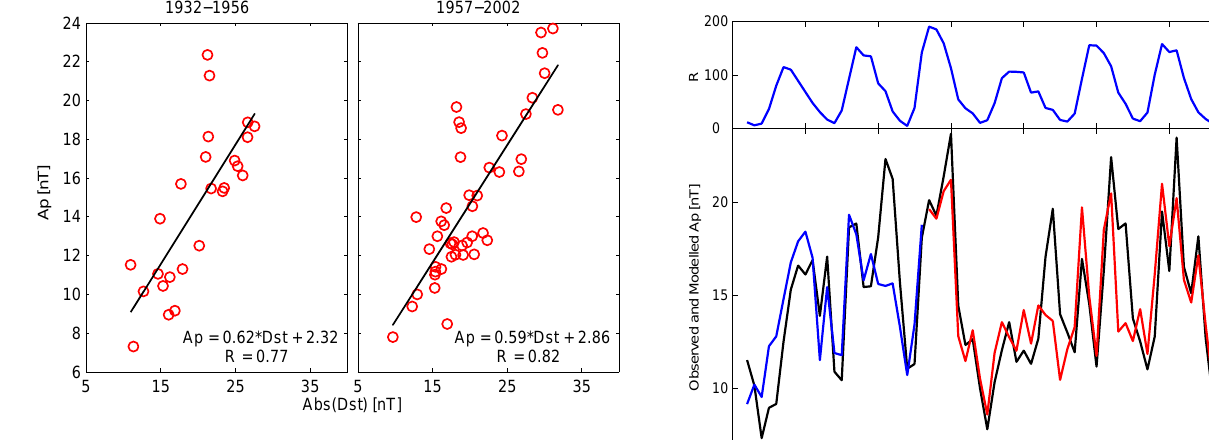
Fig. 6. Scatterplot of annually averaged A p indices vs. annually av- eraged absolute values of the reconstructed D st . Left: 1932–1956, right: 1957–2002. Best fitting lines are also given in the figure.